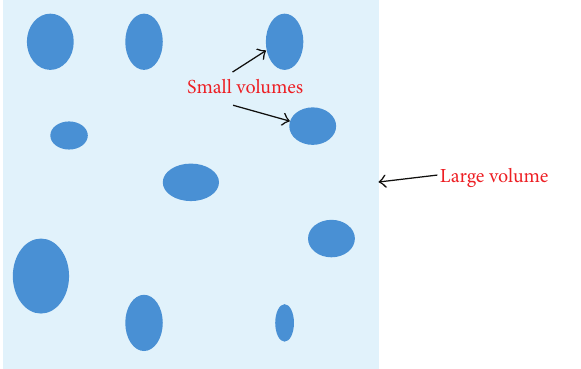
Figure 4: Swiss-cheese structure in Large Volume Scenario.